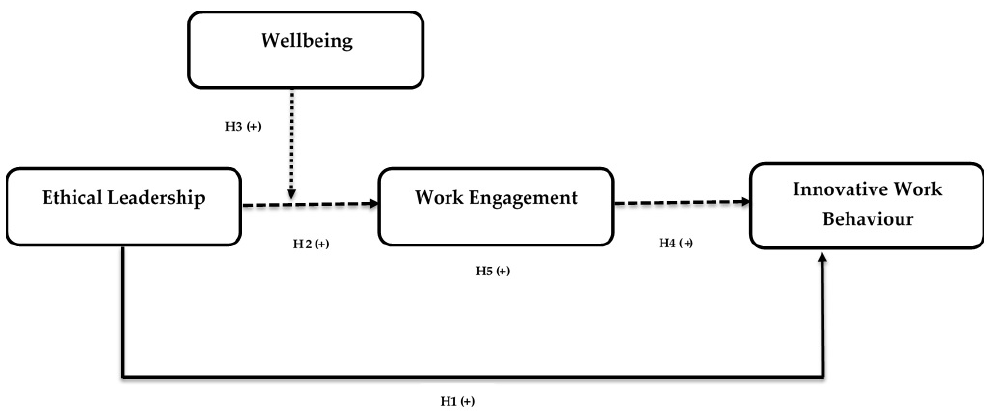
Figure 1. Conceptual Framework. Note: Solid lines show the direct relationships and dotted lines show the moderating and mediation relationships.